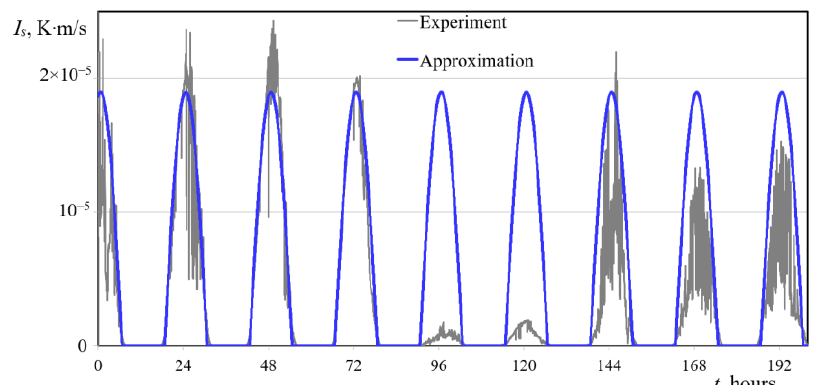
Figure 2. The radiation heat flux at the ice-water interface for the initial variant (blue line) and measured in Lake Vendyurskoe during the spring of 2020 (grey line).